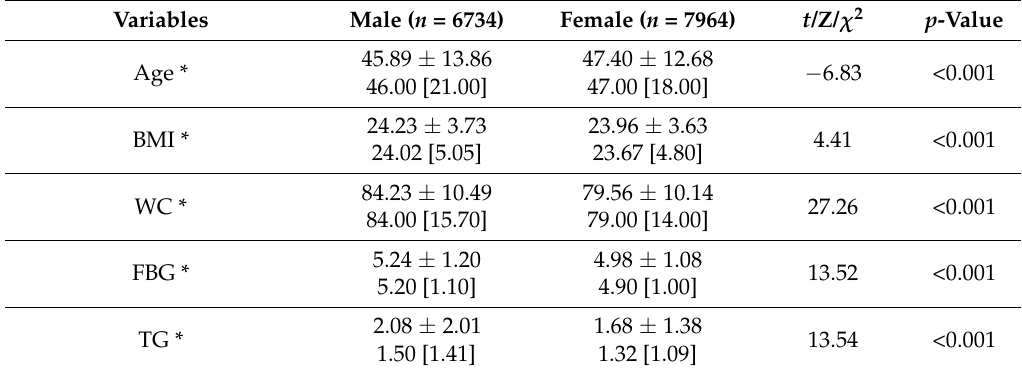
Table 1. Descriptive characteristic of participants by gender {mean ± SD/median [IQR]/ n